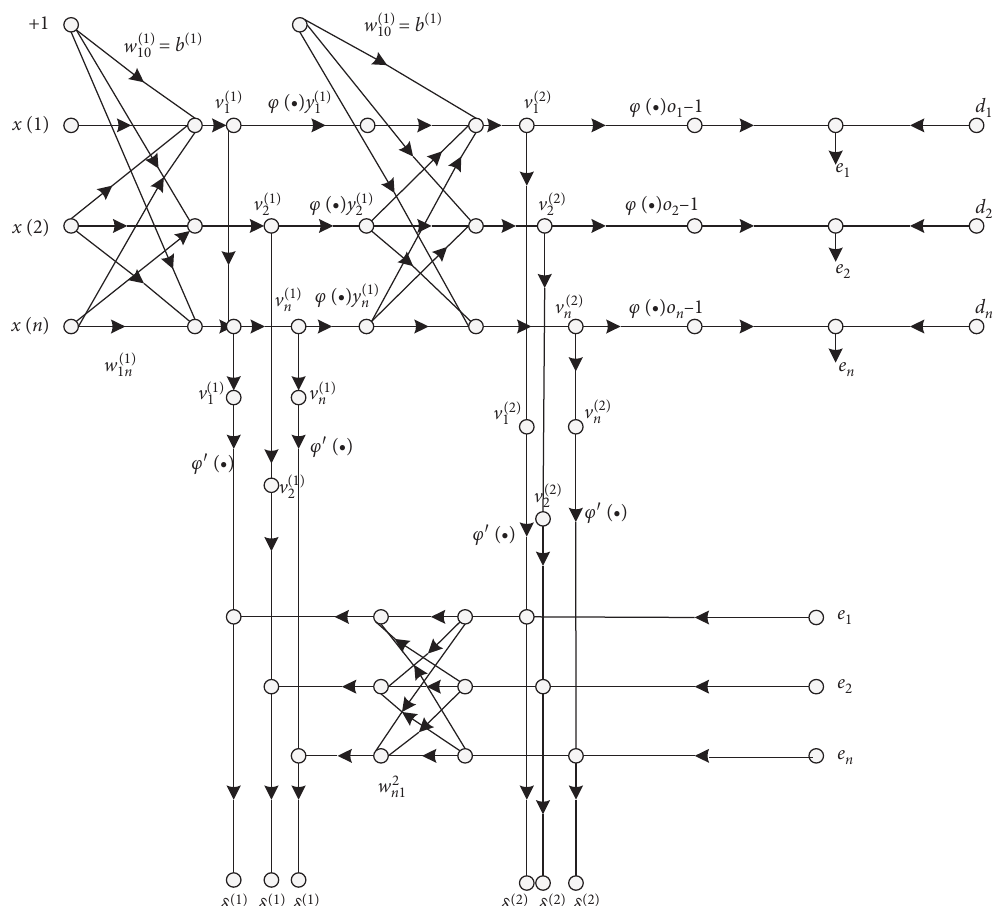
Figure 8: Fully connected neural network data flow